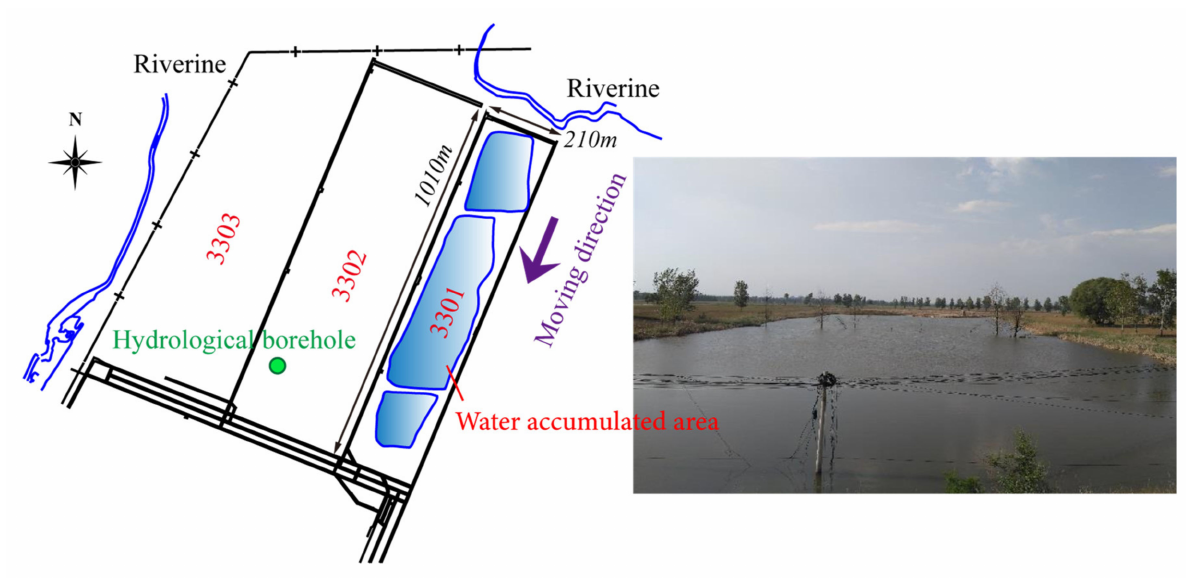
Figure 1. 3301 working face in Sanyuan coal mine and water accumulated